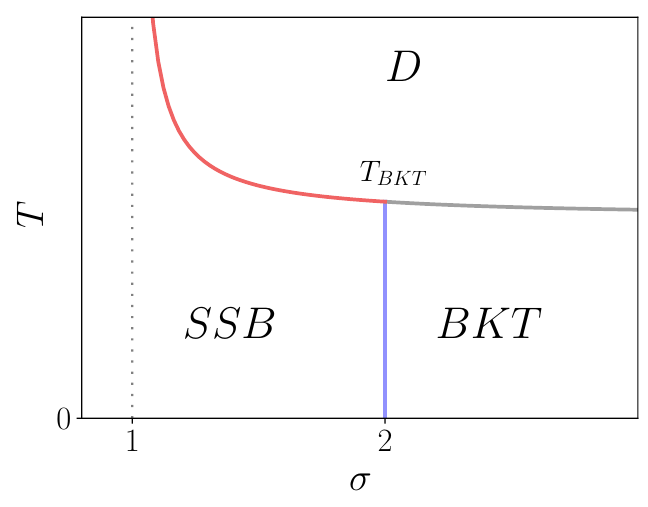
Figure 2 . Qualitative phase diagram of the long-range Villain model. For σ > 2 the system exhibits a BKT transition between the quasi-long-range-ordered BKT phase and the disordered (D) one (grey line). For 1 < σ < 2 , at low temperatures the model exhibits a low-temperature spontaneous- symmetry-broken (SSB) phase with a finite magnetization. As the temperature increases, we have a jump in the magenetization to the disordered (D) phase (red line). This transition, however, still falls within the BKT universality class. For σ → 1 + the transition temperature diverges, so that only the SSB phase survives for σ < 1